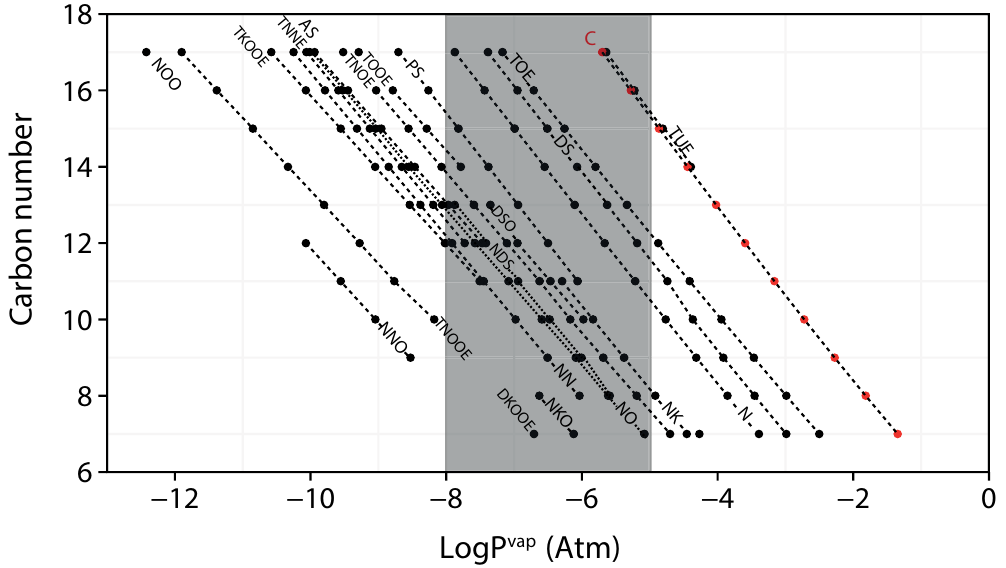
Figure 10. Saturation vapor pressure of the major products from functionalization routes simulated during n-alkane gaseous oxidation under high-NO x conditions as a function of the number of carbon atoms in the backbone. Dashed segments link two species with increasing carbon numbers within a chemical family to facilitate the reading of the figure. The grey zone represents the volatility range likely affected by gas–wall partitioning for a 1h experiment (see